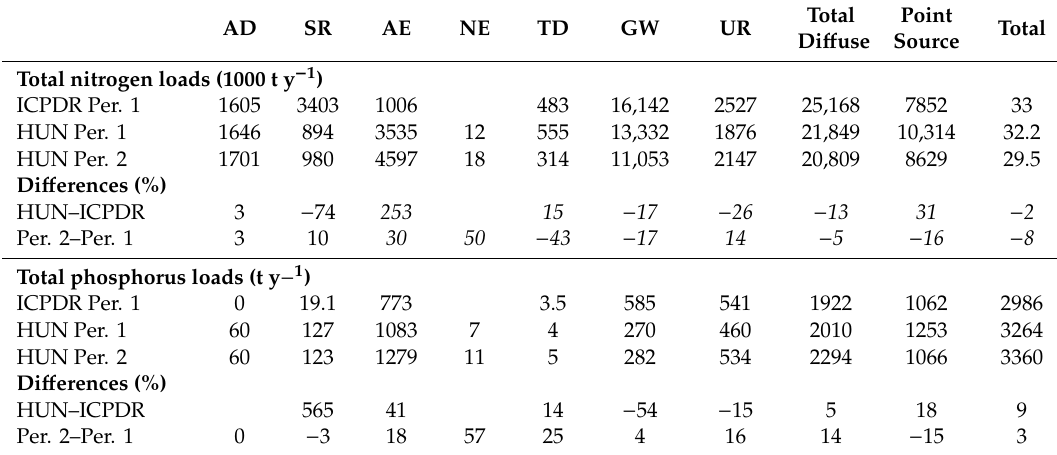
Table 9. Total nitrogen and total phosphorus loads per pathway for the two modeled periods and the ICPDR application [15]. AD = Atmospheric deposition; SR = Surface runo ff ; AE = agricultural erosion; NE = natural erosion; TD = tile drainage; GW = groundwater; UR = urban runo ff . ICPDR = the ICPDR application; HUN = the present study. Per. 1 = years 2009–2012; Per. 2 = years